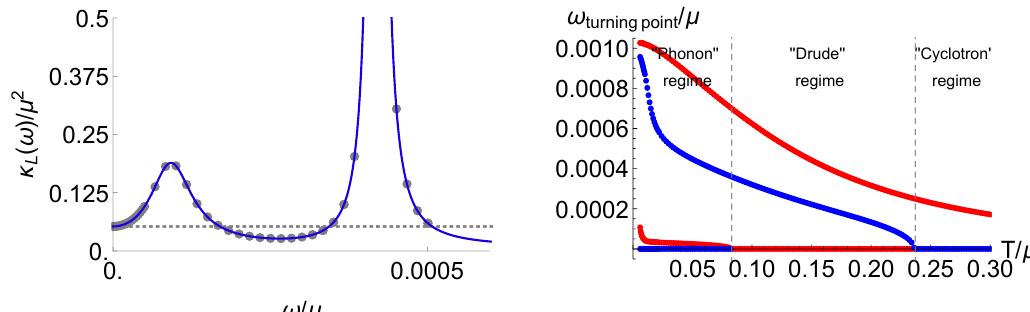
Figure 3. Conductivities in the (pseudo-) explicit breaking regime. Left: the AC longitudinal thermal conductivity at λ/µ = − 10 − 5 , k/µ = 0 . 1 , B/µ 2 ≈ 3 × 10 − 4 and T/µ = 10 − 2 . Notice the two peaks, both displaced from ω = 0 . Right: the frequency of the maxima (red) and minima (blue) in the hydrodynamic longitudinal electric charge conductivity as a function of temperature at λ/µ = − 10 − 5 , k/µ = 0 . 1 and B/µ 2 = 10 − 3 . At the lowest temperatures we have two peaks in the ω > 0 half-line and also a minimum at ω = 0 . As the temperature increases the two pseudo- Goldstone modes join ( T/µ ≈ 0 . 083 ) to become a single Drude-like peak at zero frequency. This zero frequency peak eventually drops out of the correlator, becoming a trough, at T/µ ≈ 0 . 237